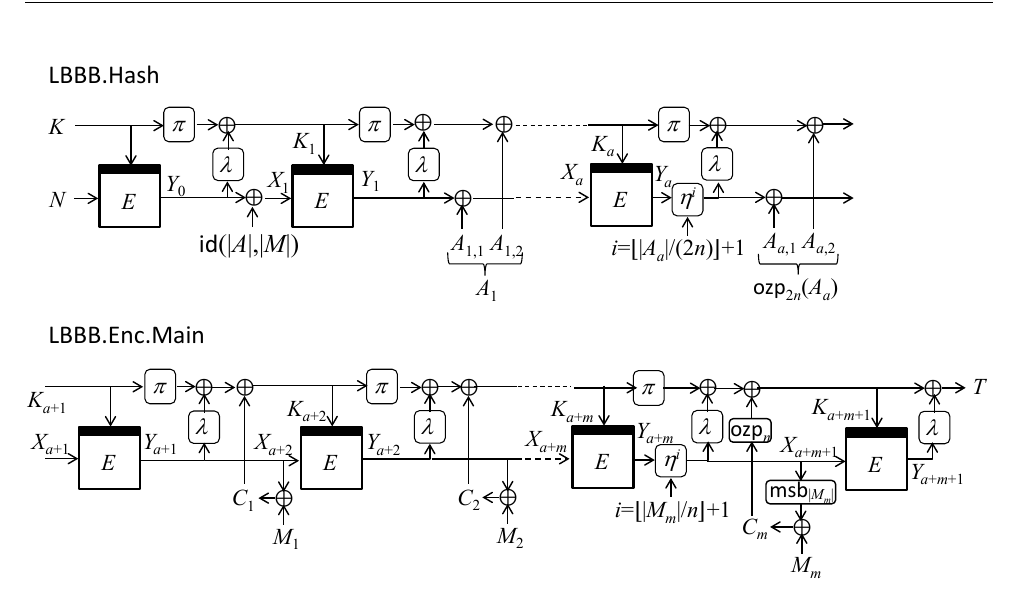
Figure 2: Encryption of LBBB . N , K , A and M are a nonce, a secret key, associated data, and a plaintext. id ( | A | , | M | ) is a constant to distinguish whether A = ε or not and whether M = ε or not. ( A i, 1 , A i, 2 ) is an i -th pair of associated data blocks, M i /C i is